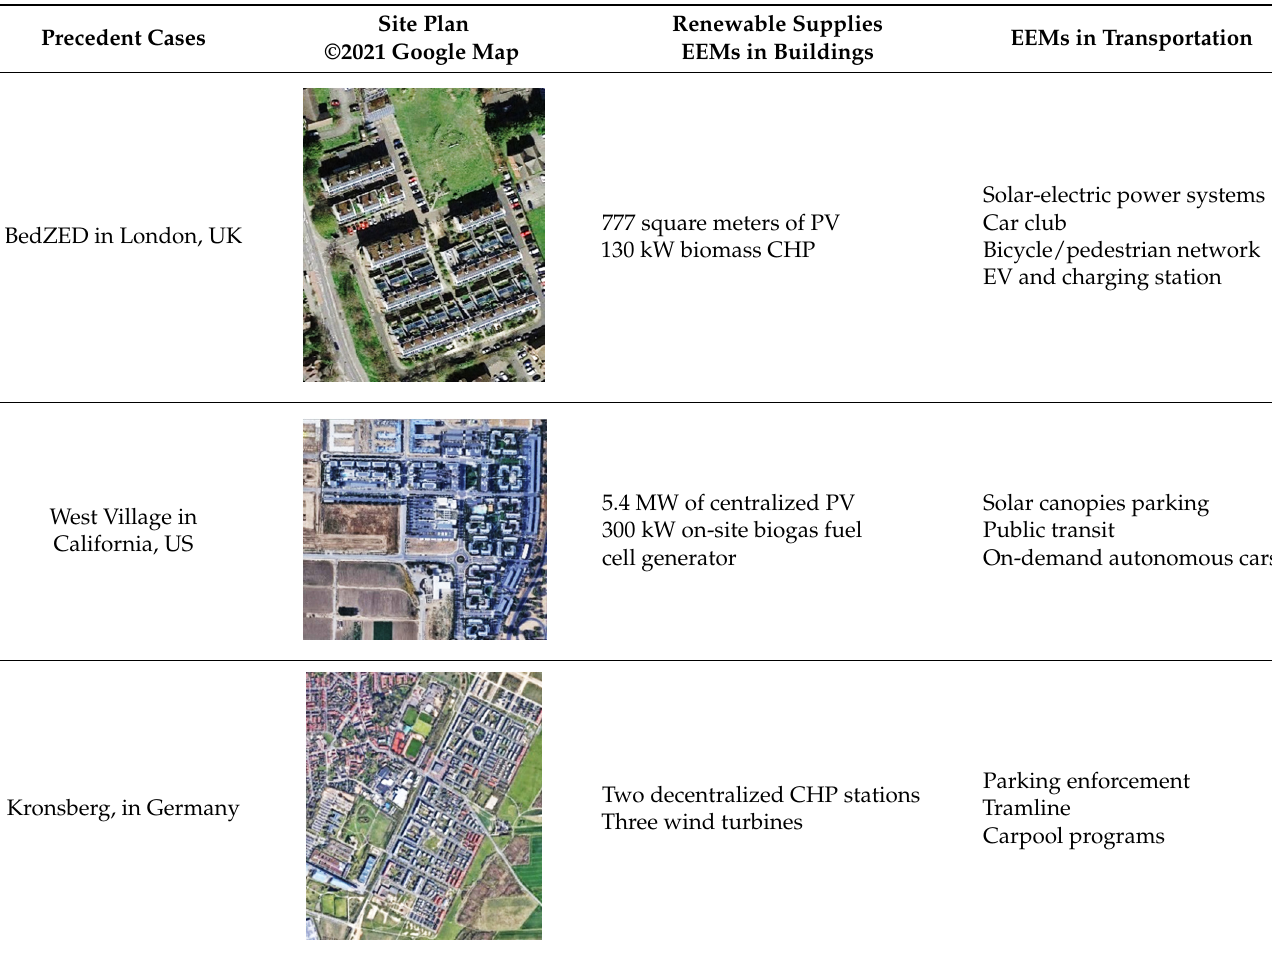
Table 6. Snapshot of three worldwide planned net zero communities with their main energy indicators.